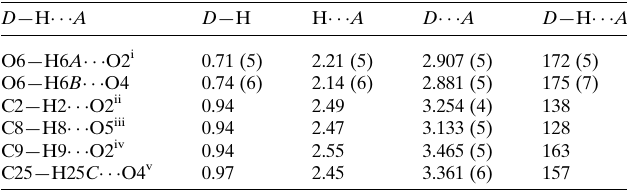
Table 1 Hydrogen-bond geometry (A˚ , (cid:3) ).